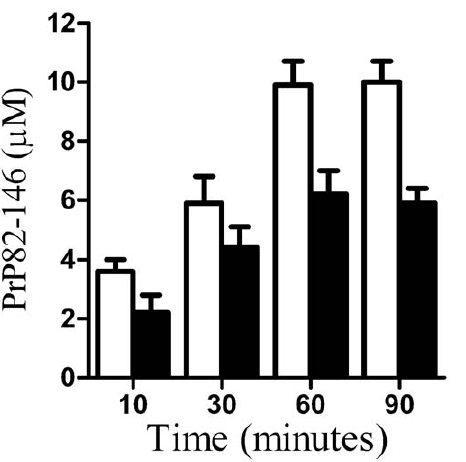
Figure 10. Glimepiride reduced the binding of PrP82–146 to neurones. The amount of PrP82–146 in cell extracts from cortical neurones pre-treated for 1 hour with a vehicle control ( % ) or with 5 m M glimepiride ( & ) and exposed to 10 m M PrP82–146 for different times periods as shown. Values shown are the mean average amount of PrP82–146 ( m M) 6 SD, n=9.